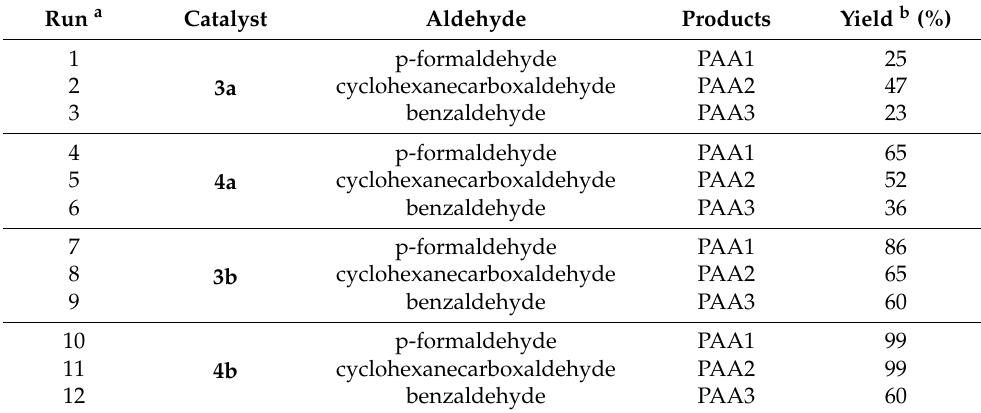
Table 1. Catalytic activity of Ag-NHC and Au-NHC in A 3 -coupling reactions.